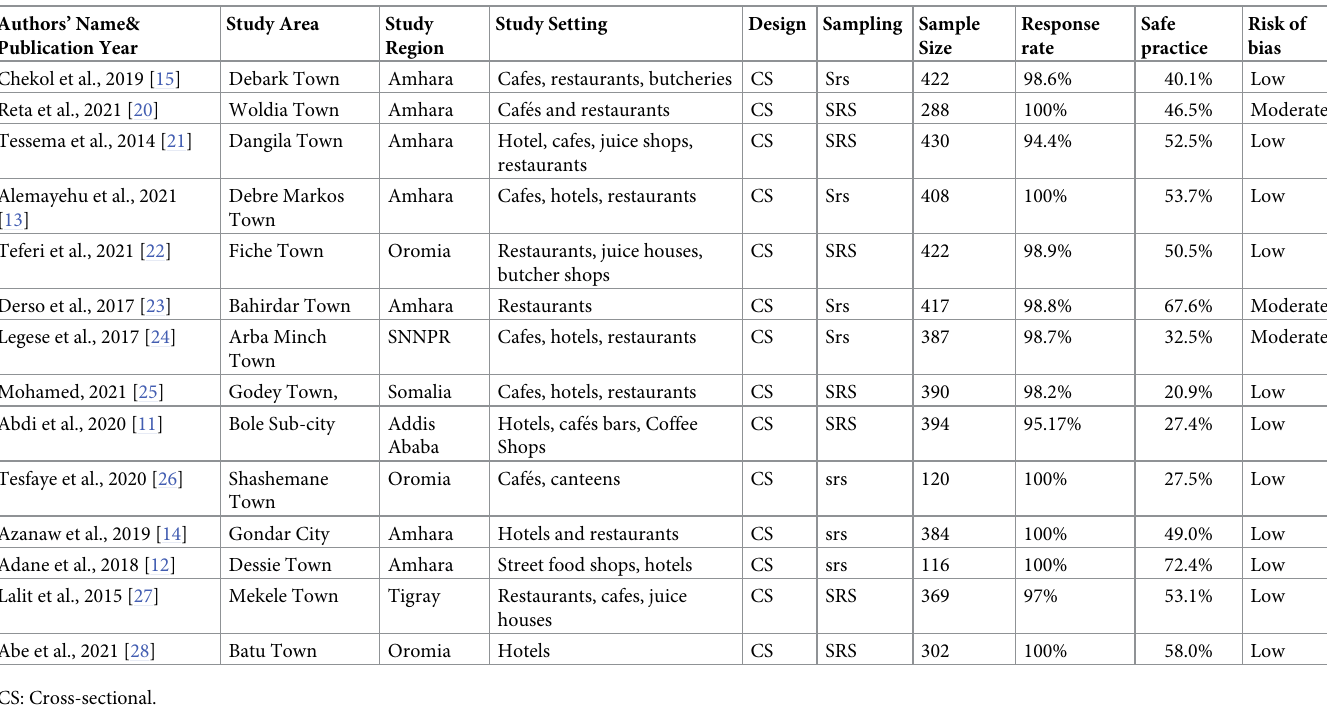
Table 1. Baseline characteristics of the included studies,